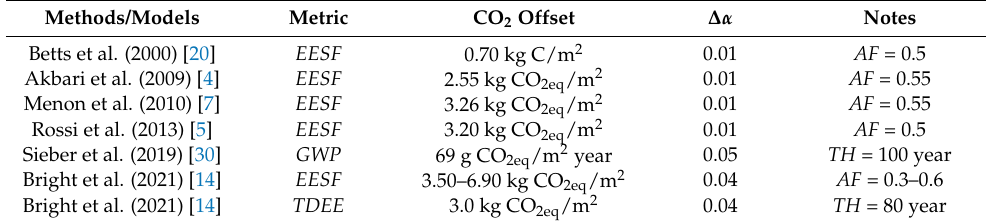
Table 1. Comparison among methods for CO 2 offset